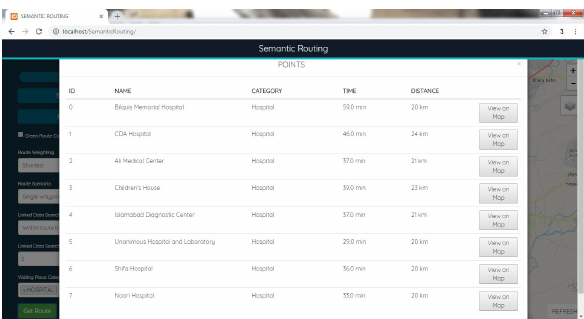
Figure 8. Display of Linked Data PoIs with route summary